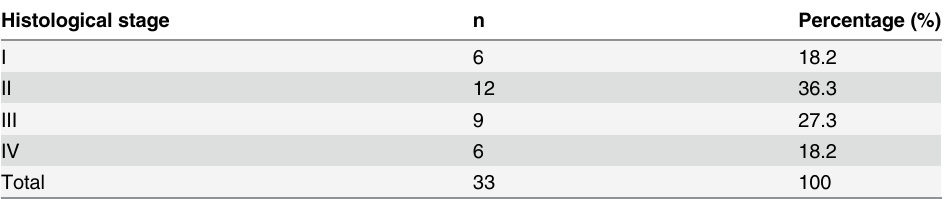
Table 1. Histological stages in PBC